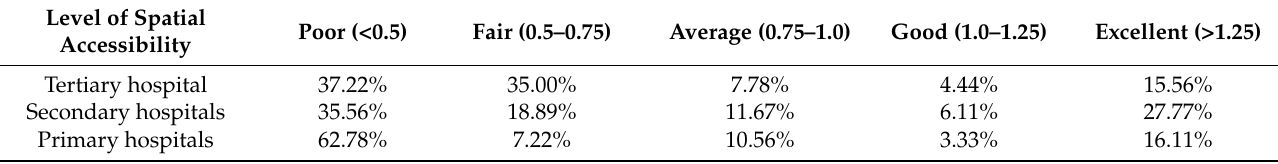
Table 7. Levels of spatial accessibility of different-grade medical facilities in Changning District. Level of Spatial